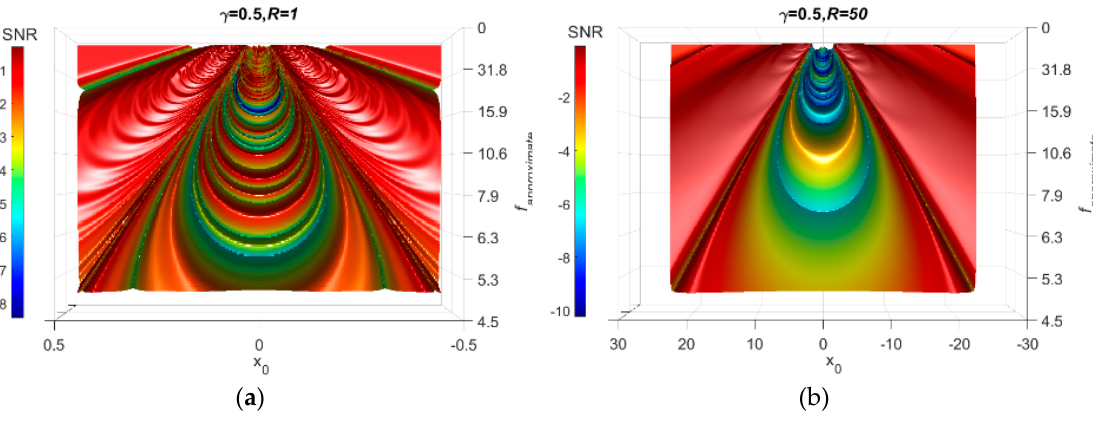
Figure 7. Influence of damping on the FI-UPRS method. ( a ) γ = 0.05 ( b ) γ = 0.5 ( c ) γ = 0.95.